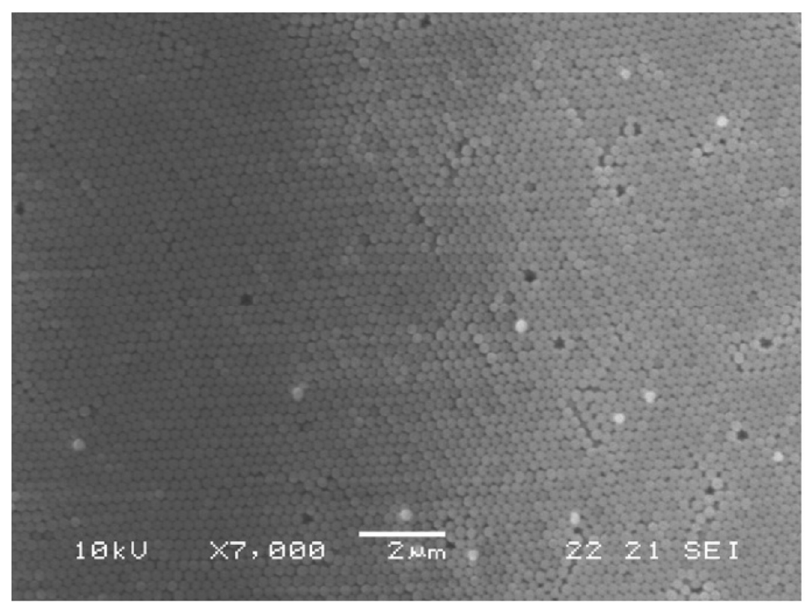
Figure 6. SEM micrograph of the top surface of the opal structure formed by the vertical deposition method of 270 nm diameter silica spheres. Reproduced with permission from [72], copyright 2007, Elsevier.